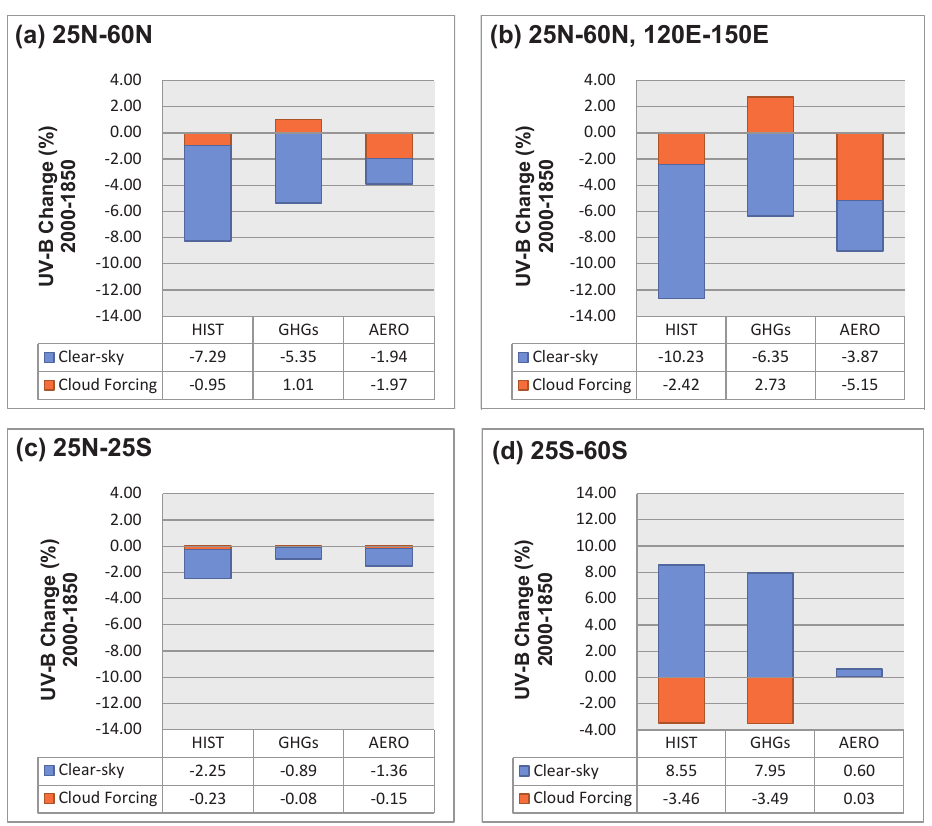
Fig. 4. Attribution of UV-B responses to each anthropogenic forcing (see